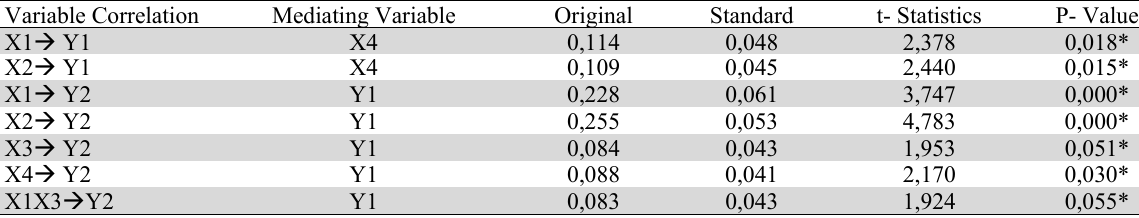
Indirect Effects of Exogenous Variables on Endogenous Variables through Mediation Variables Variable